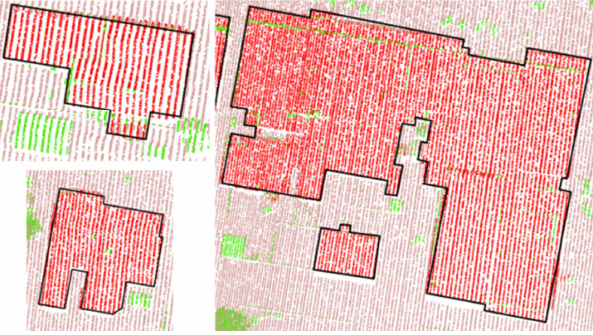
Figure 10. Footprint reconstruction of complex buildings with high density LiDAR